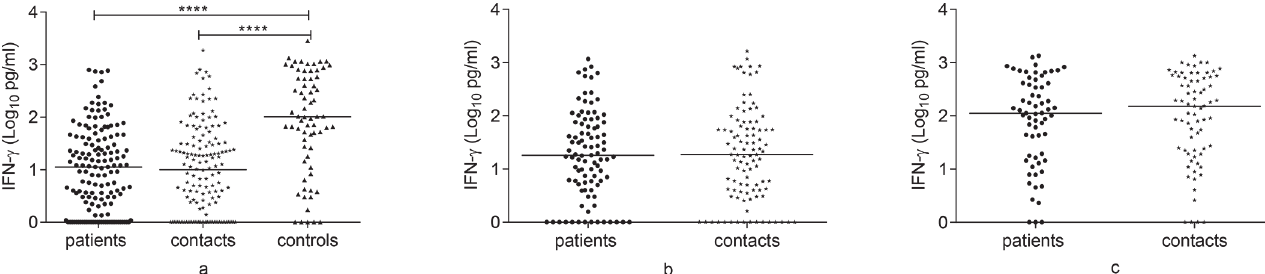
Fig 1. Comparison of IFN- γ response to Rv2031 among groups at baseline, 6 and 12 months. IFN- γ response at baseline (a), 6 months (b) and 12 months (c) following whole blood stimulation with Rv2031 for 48 hours. Filled circles represent patients, filled diamonds represent contacts and filled triangles represent controls. Results are individual responses and cytokine levels are expressed as log 10 pg/ml. Horizontal bars are medians. Kruskal-Wallis test with Dunn ’ s multiple comparisons (a) and Mann-Whitney test (b and c) were used to compare groups. **** p < 0.0001.